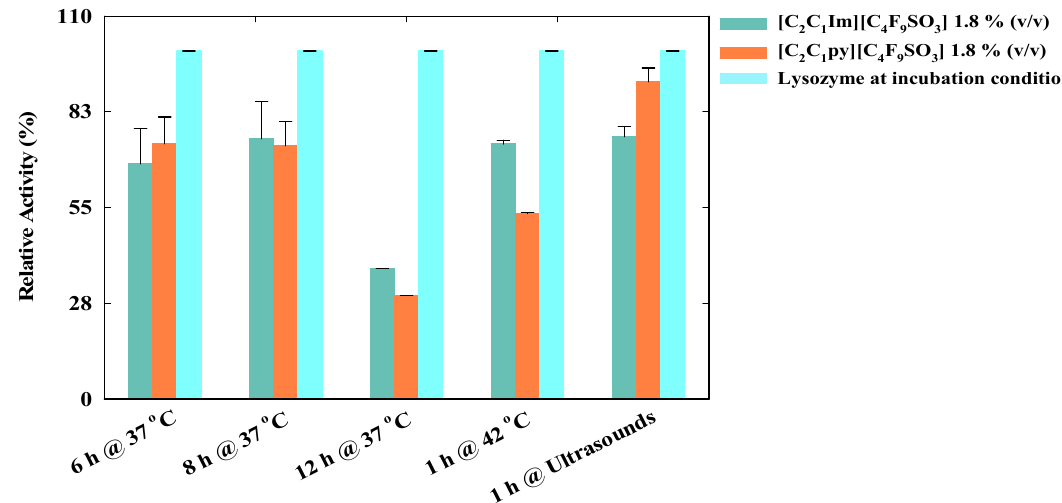
Figure 5. Relative activity of the released lysozyme (0.2 mg / mL) in [C 2 C 1 Im][C 4 F 9 SO 3 ] and [C 2 C 1 py][C 4 F 9 SO 3 ] after the exposure at several external stimuli.